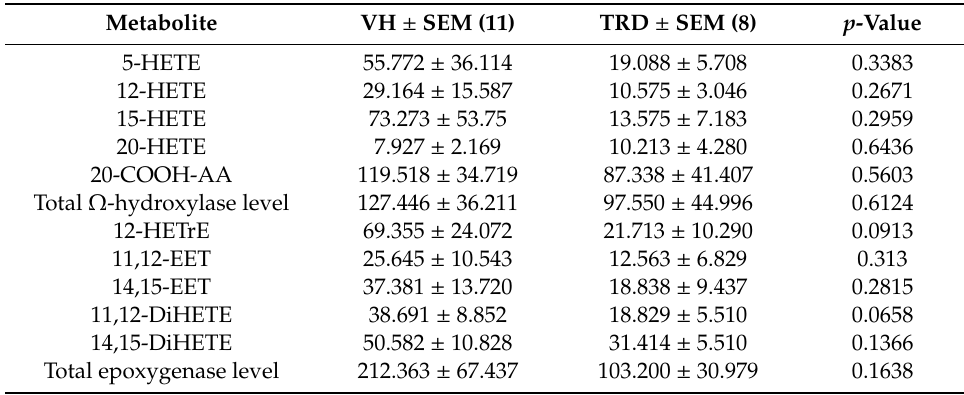
Table 2. Mean levels (pg / mL) ± standard error of measurement (SEM) of lipoxygenase and cytochrome P450-derived eicosanoids in bevacizumab-treated human vitreous in vitreous hemorrhage (VH, n = 11) vs. tractional retinal detachment (TRD, n = 8)